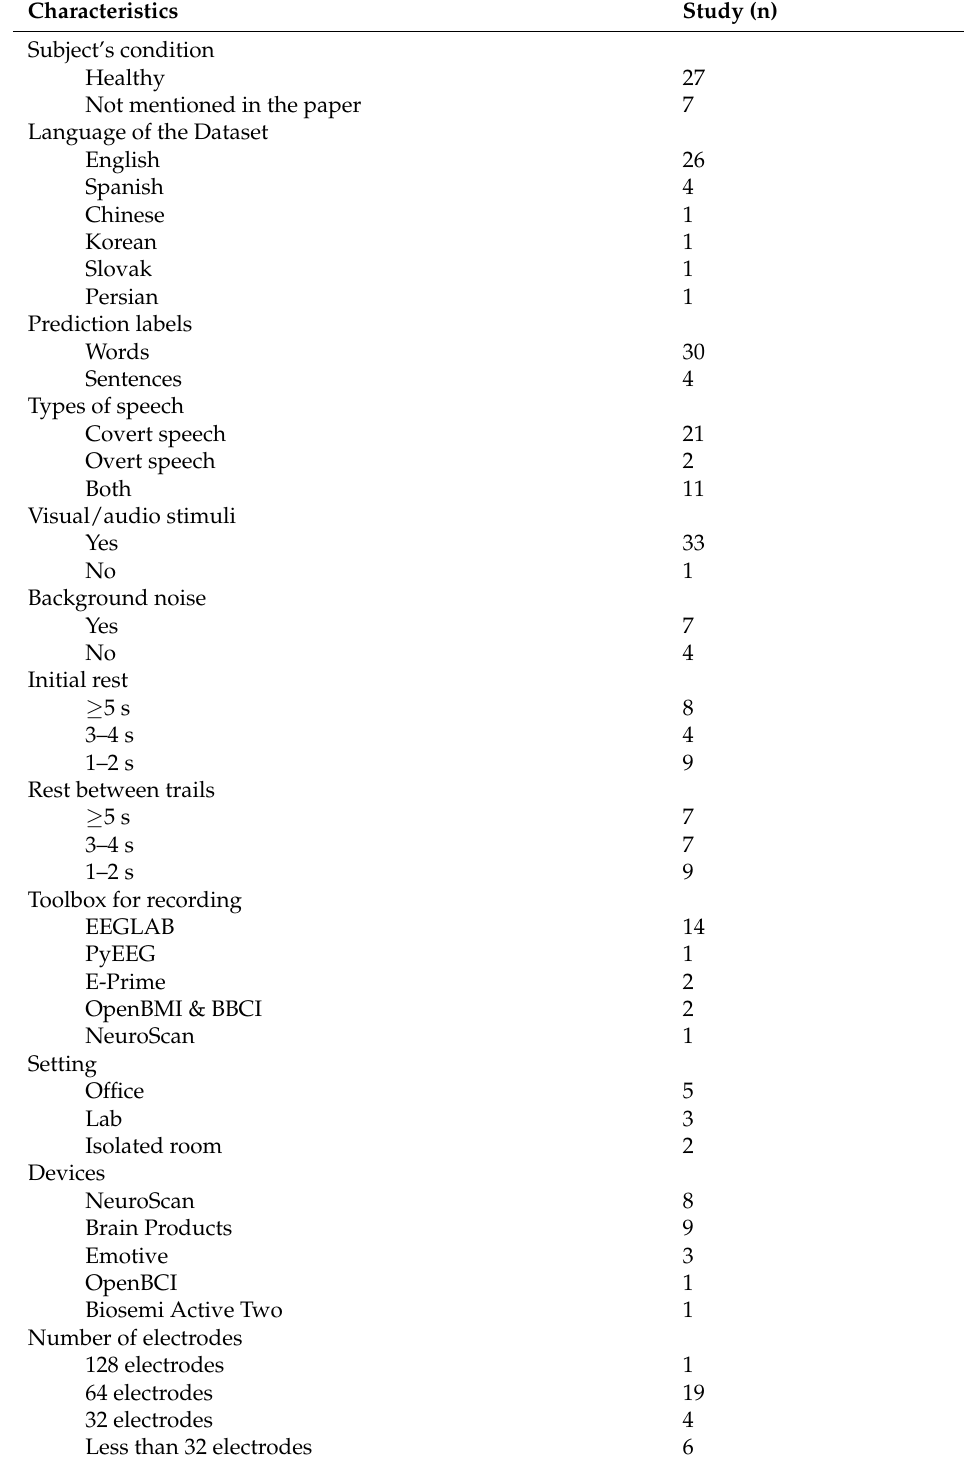
Table 4. Characteristics of Data Acquisition from EEG